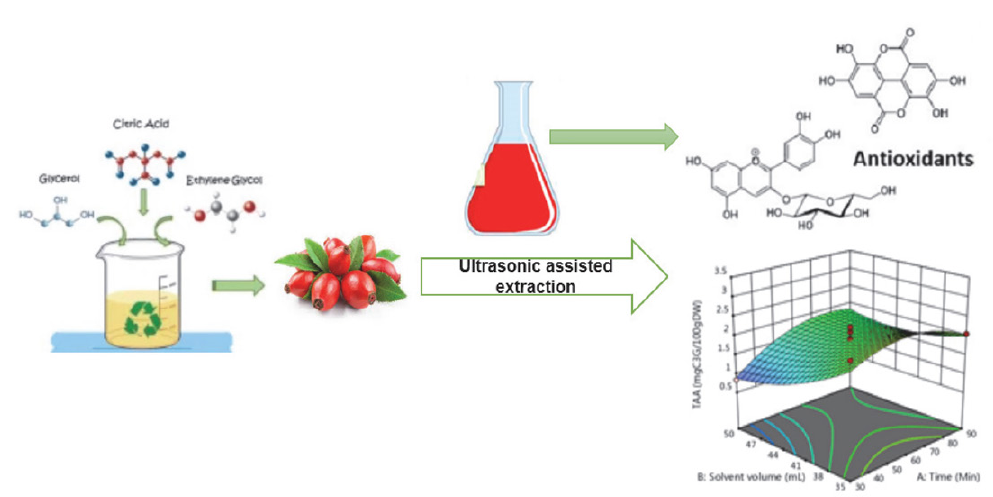
Figure 1. Experimental design for extraction bioactive compounds from Rosa canina L.